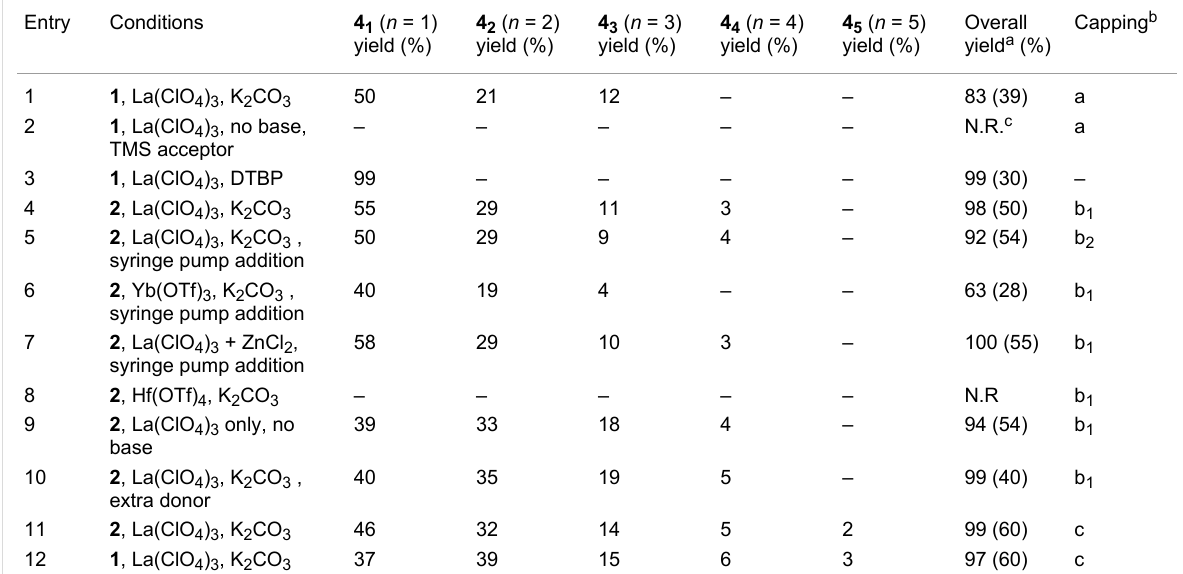
Table 1: Optimization of oligomerization reaction